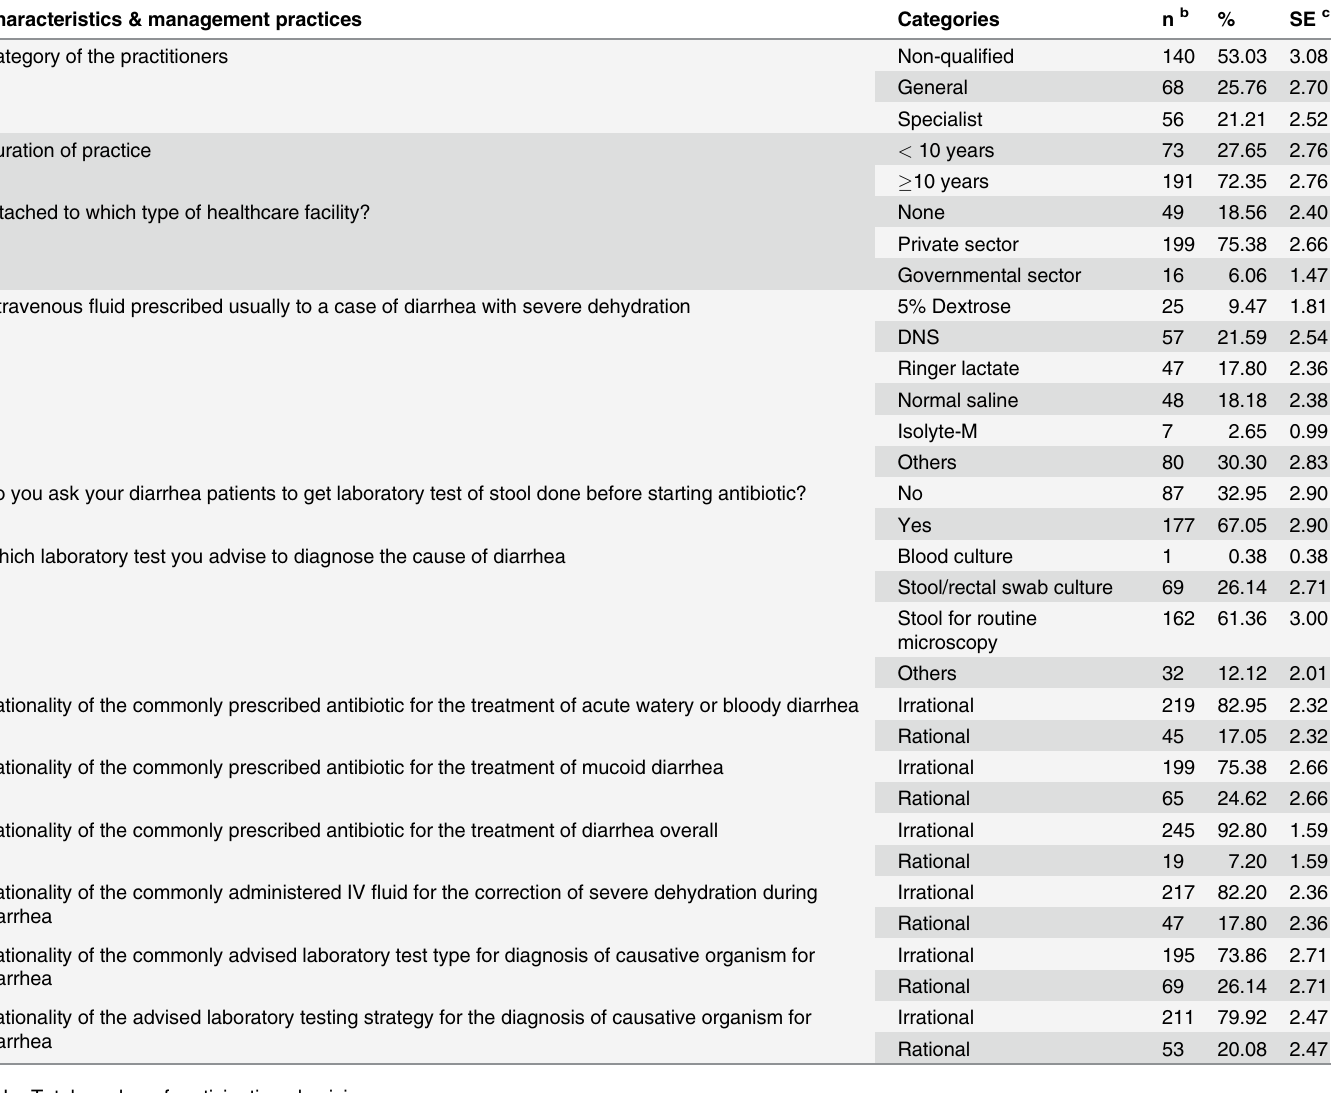
Table 1. Distribution of the characteristics and diarrheal management practices among participating physicians (N = 264 a